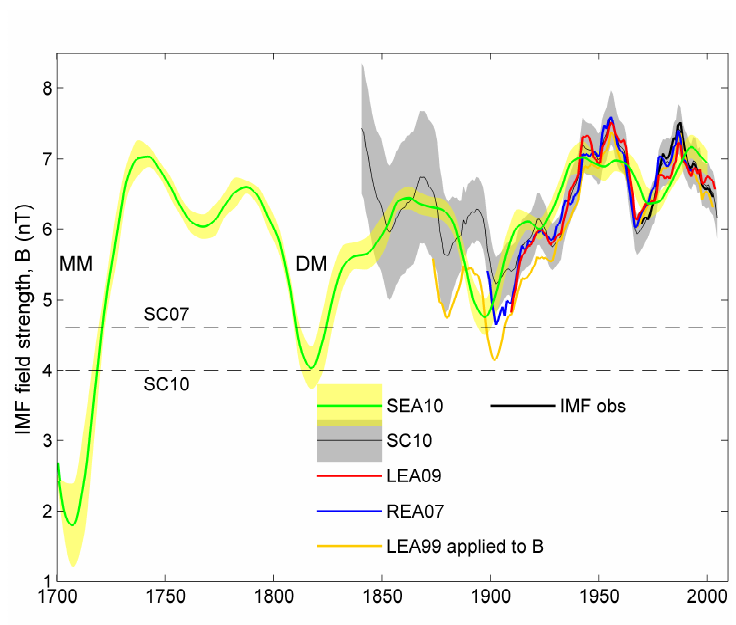
Figure 34: Long-term variations of 25-year means in the IMF 𝐵 derived from 10 Be cosmogenic isotope data by Steinhilber et al. (2010) (SEA10): the green line is the best estimate and the yellow band the estimated uncertainty. In addition, 11-year running means of the reconstructions from geomagnetic activity, as presented in Figure 26, are shown using the same colour scheme as in that figure. Also shown are the SC07 and SC10 floor estimates for annual means and the Dalton and Maunder sunspot minima are labelled DM and MM. Image reproduced by permission from Lockwood and Owens (2011), copyright by